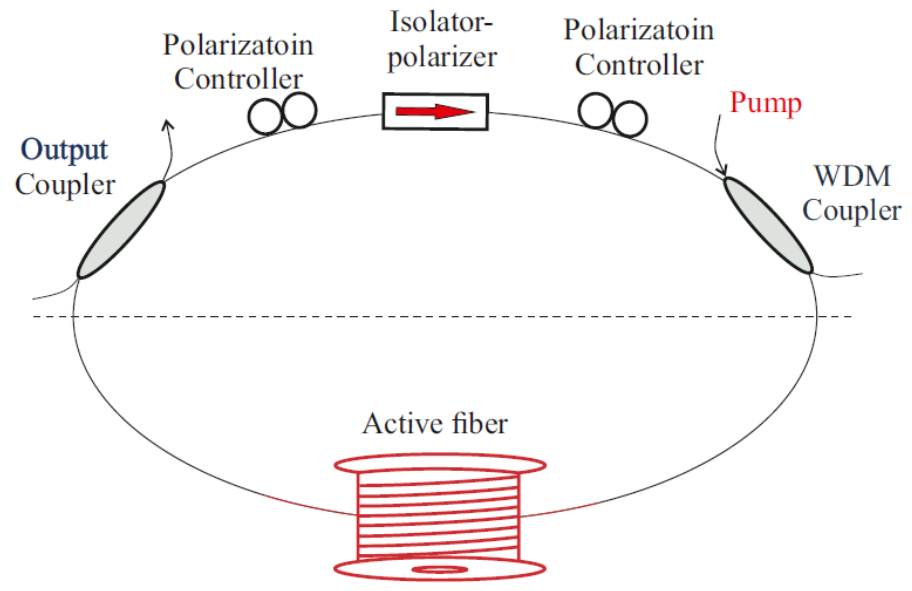
Figure 19. Operating principle of a fiber laser with NEP.